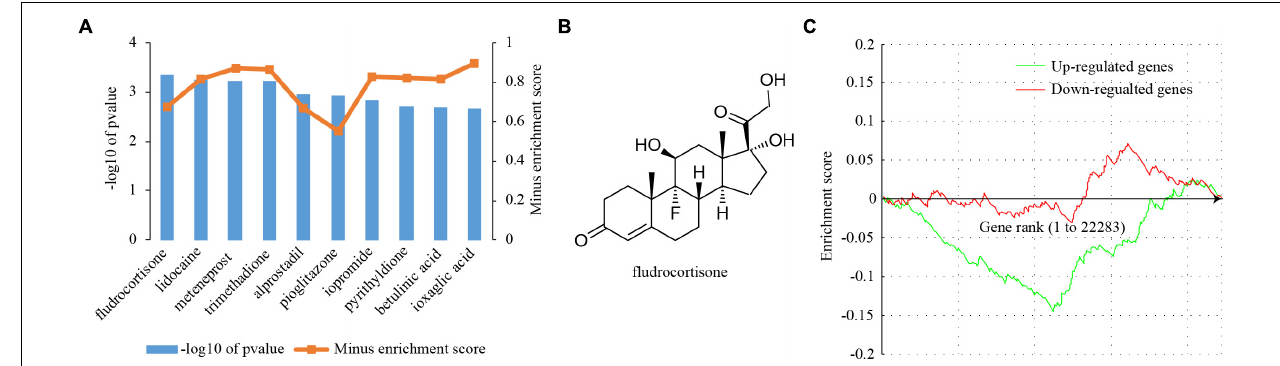
FIGURE 6 | Connectivity map (CMap) analysis. (A) The enrichment scores of the top 10 chemical drugs from CMap analysis. Differentially expressed genes were queried into CMap and chemical drugs showing a negative enrichment score were considered. (B) The molecular structure of the top-ranked chemical drug, fludrocortisone. (C) A graphical view of the enrichment score for fludrocortisone. The enrichment score is determined by computing a Kolmogorov–Smirnov (KS) statistic separately for the up- and down-regulated